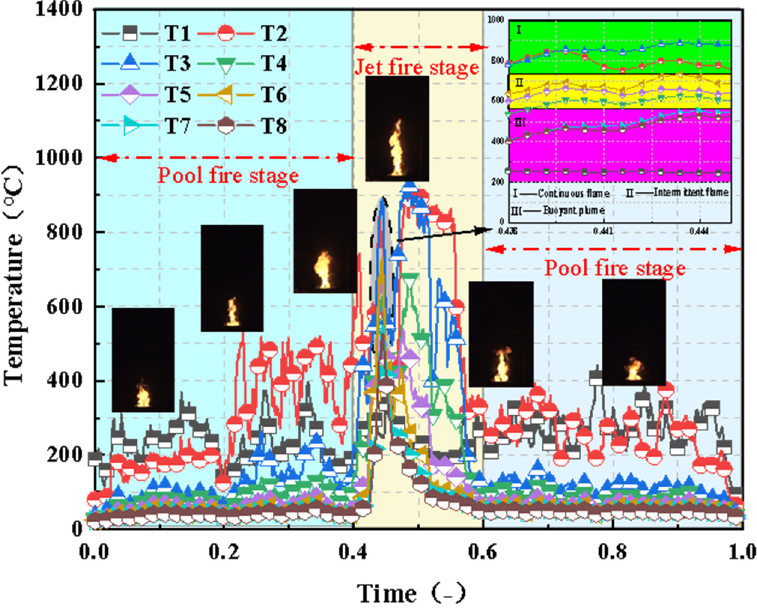
Figure 3. Temperature distribution measured along the central axis of the jet fire (D = 0.4 m/d = 10 cm).